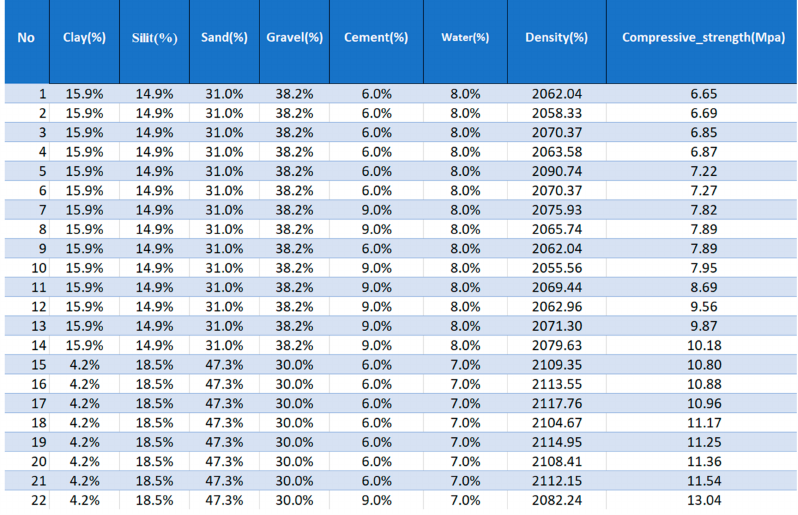
Figure 4. Part of the database is placed in a separate fold of enclosed